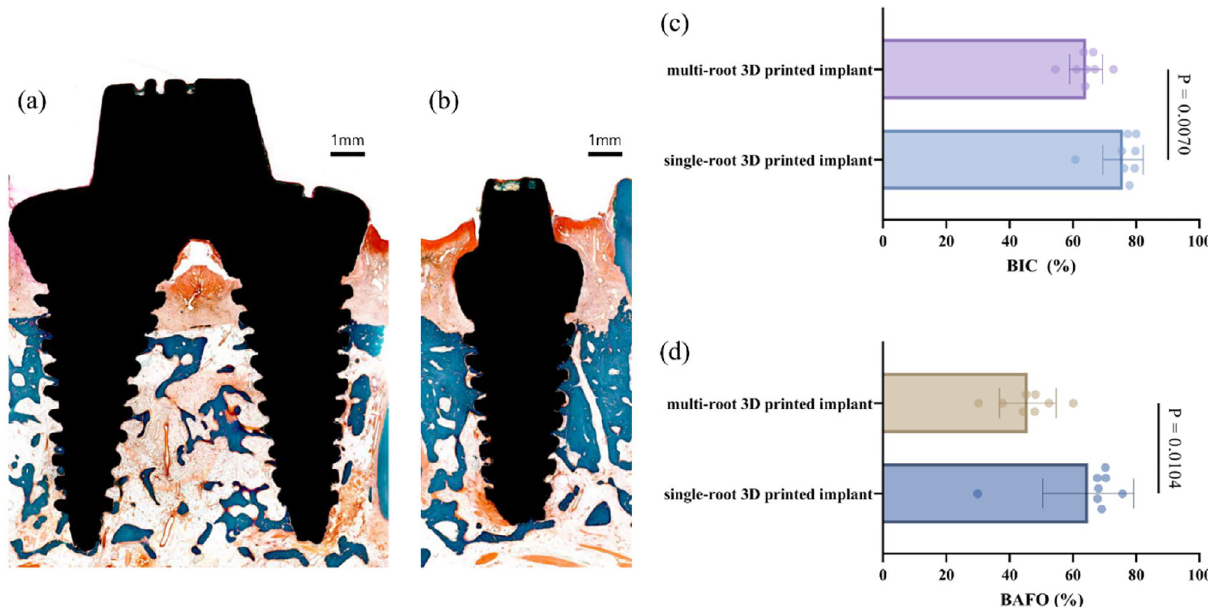
Figure 5. Representative of histologic view ( a , b ) and analysis ( b , d ). ( a )Histomorphometric view of double- root 3D-printed implant. Note the bone resorption in the furcation area. ( b ) Histomorphometric view of single-root 3D-printed implant ( c ) The BIC in single-root and multi-root 3D-printed implants had statistically significant difference (75.87% ± 6.32% and 64.18 ± 5.23%, respectively, p = 0.0070) ( d ) The BAFO was statistically significantly different ( p = 0.0104) in single-root and multi-root 3D-printed implants (64.88 ± 14.37% and 45.81 ± 9.01%, respectively). 3D: 3-dimensional, BIC: bone-to-implant contact, BAFO: bone area fraction